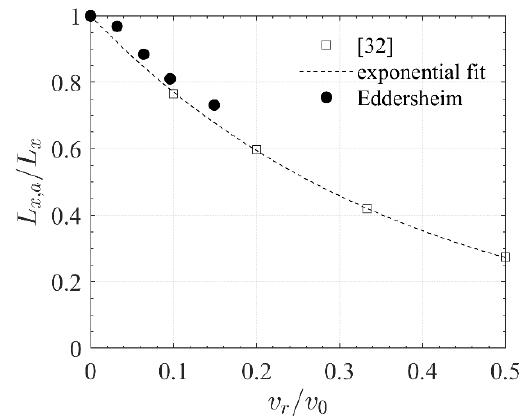
Figure 7. Reduction of the normalized propagation length L x , a / L x of turbulent jets in reverse flows for velocity ratios v r / v 0 as obtained from [32]. Normalization with propagation length L x without reverse flow. Approximation with an exponential fit (Equation (9)). Comparison with results from 3D-hydrodynamical simulations in the tailrace of Eddersheim Dam.